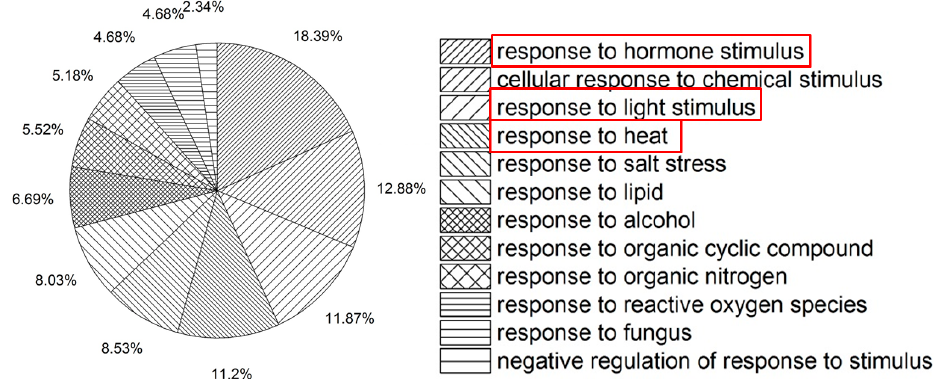
Figure 1. GO enrichment analysis of differentially expressed genes to HS treatment. GOEAST analysis reveals that the heat stress (HS)-induced differentially expressed genes are enriched into several biological processes (see original map in Supplemental KEGGS and GOEASTs). A statistics summary of biological processes on Level 4 (the 4th rank of GOEAST-biological_process, see Supplementary GOEAST GENE LIST) is presented here. On this level, 18.39% and 11.87% of the HS-induced genes are involved in hormone stimulus and light stimulus response, respectively. (Genes involving more than one category are double-counted. Red frames highlight the three “responses”.)